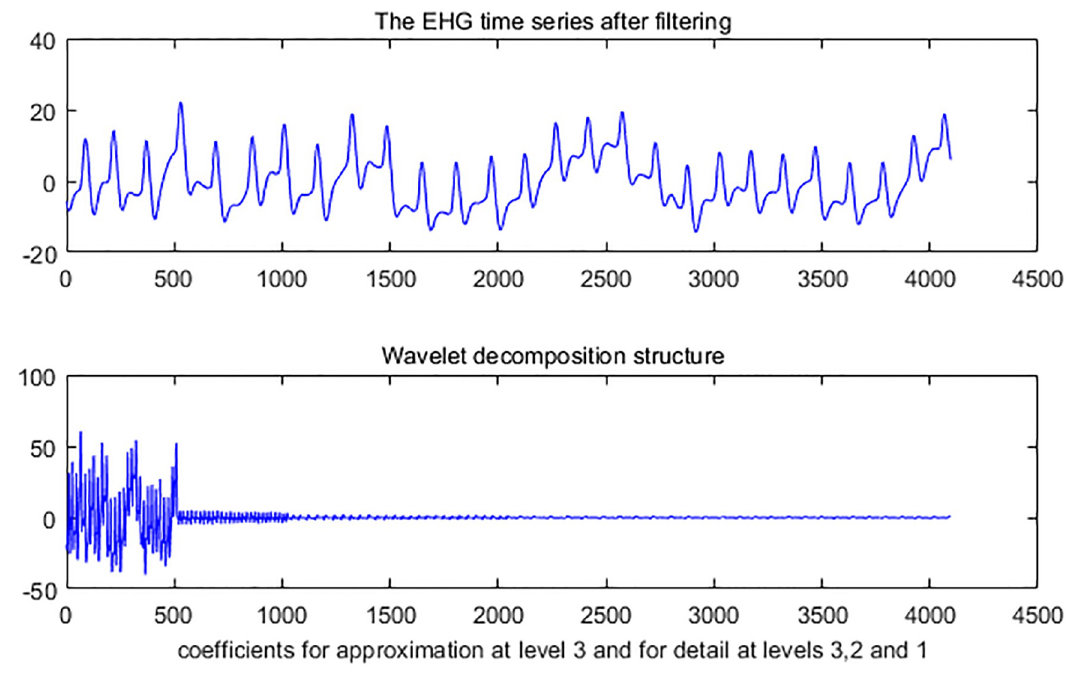
Fig 6. The decomposition of one EHG time series after